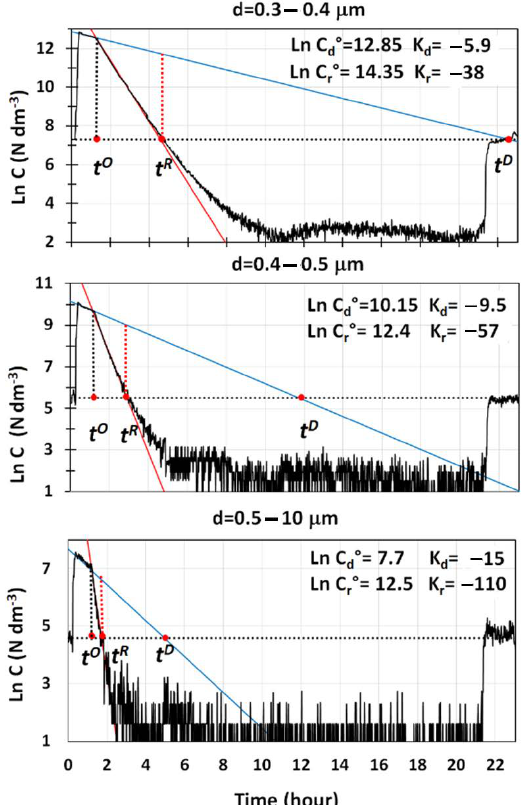
Figure 7. Semi-logarithmic plots of particle number concentration vs. time recorded, in the experi- ment performed with diesel exhaust emission using the SANINDOR prototype as air cleaner. The meaning of the lines and symbols are the same as in Figures 2–4. Values of the slopes and intercepts of the regression lines for natural deposition/adsorption ( d ) and by removal by cleaning ( r ), are reported in the figure. They are calculated with the value of t = 0, indicated in the text as t IN